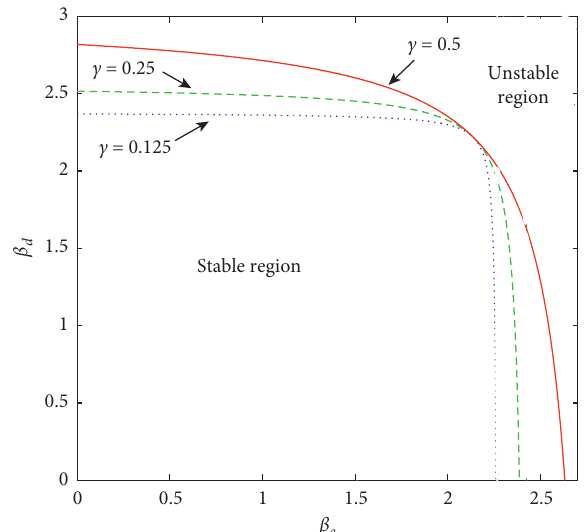
Figure 2: Stability region of the Nash equilibrium with respect to ( β , β ) under different c e d